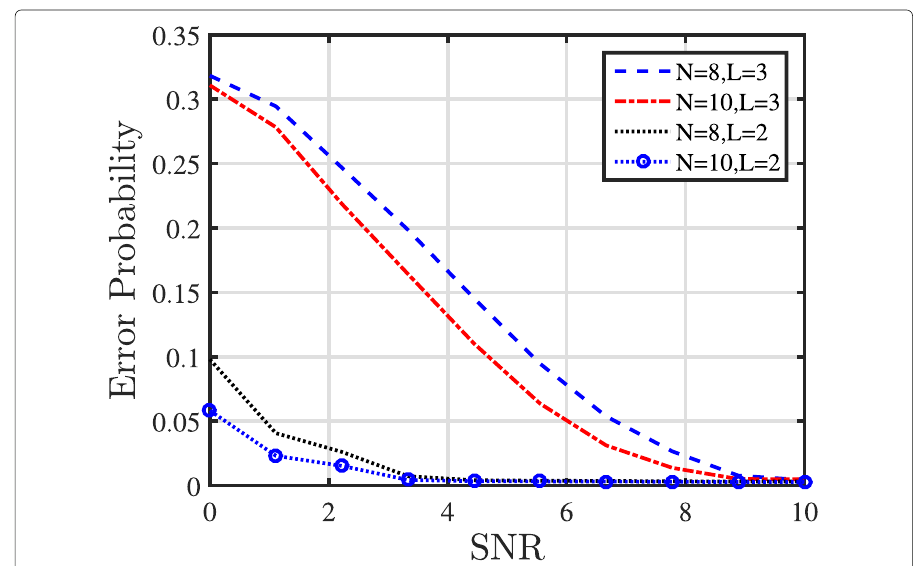
Fig. 9 Error probability of the GWT classifier for different channel conditions and number of observation vectors for D={8PSK, QPSK, BPSK}